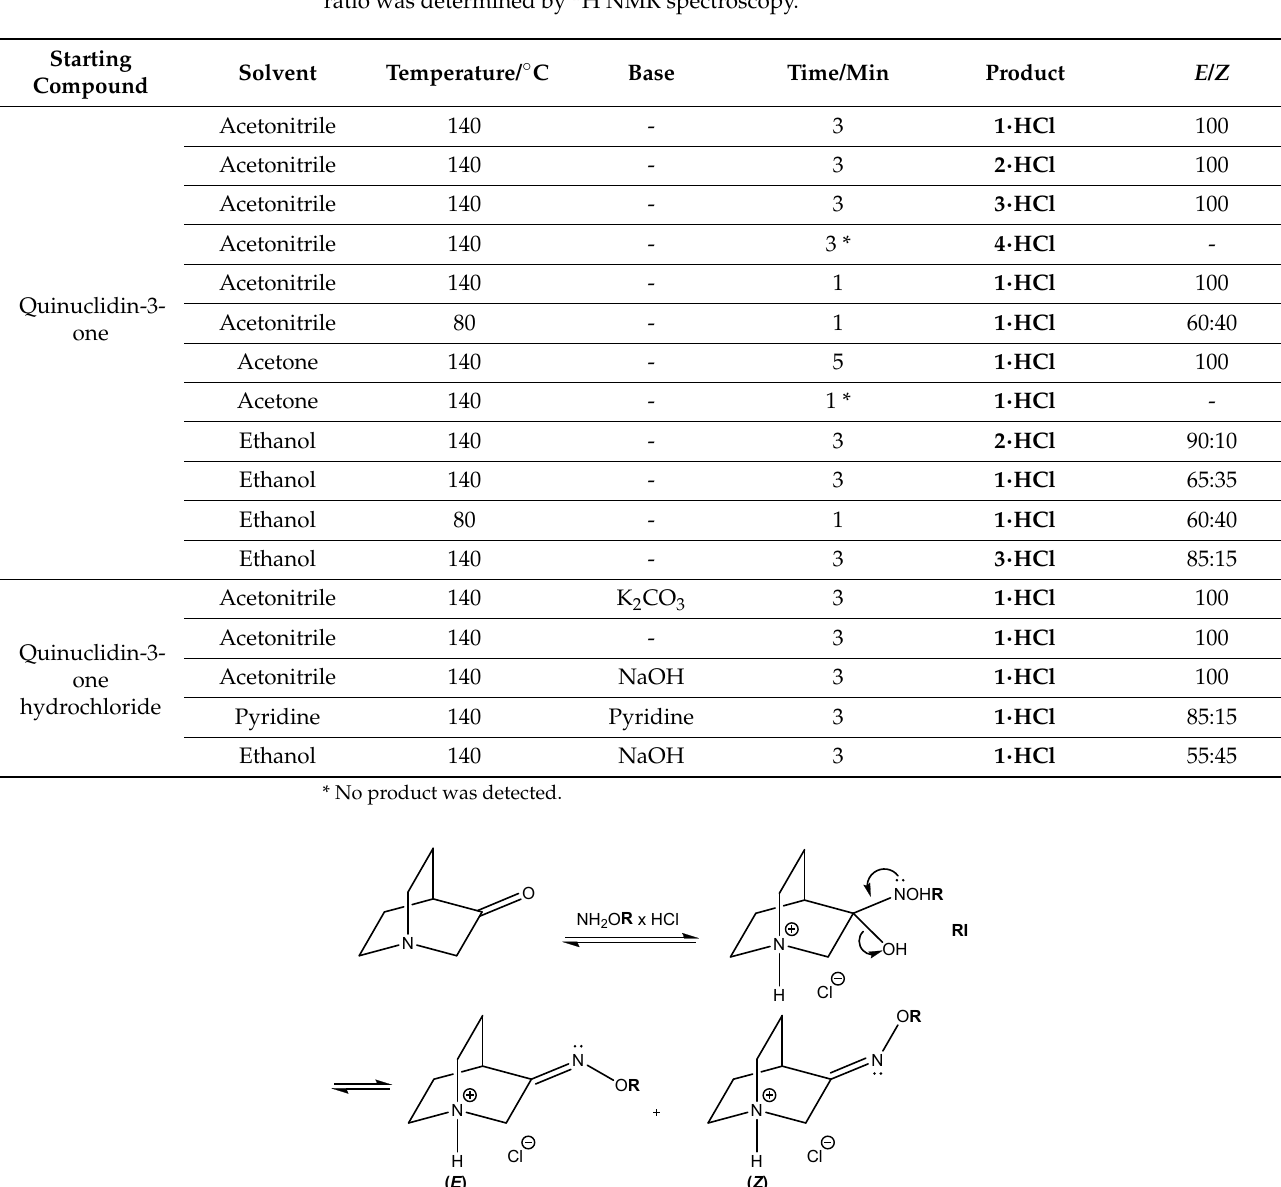
Table 3. Reaction conditions for microwave synthesis (Method C) of compounds 1 · HCl – 4 · HCl . E / Z ratio was determined by 1 H NMR spectroscopy.